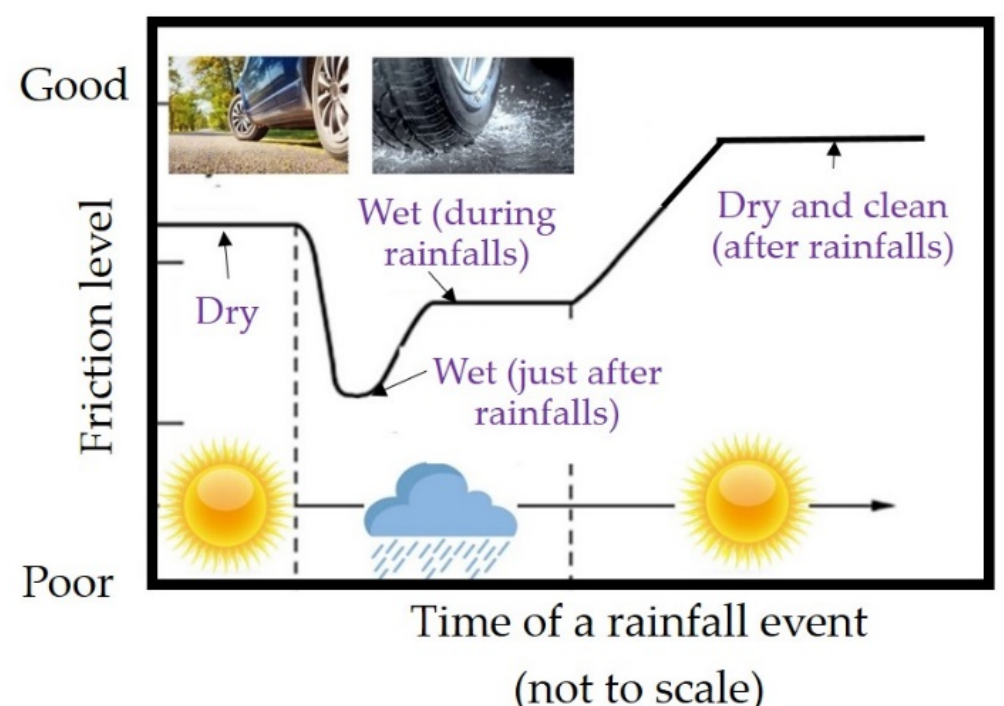
Figure 6. Friction level variations of a pavement surface subject to weather changes (adapted from [55]).